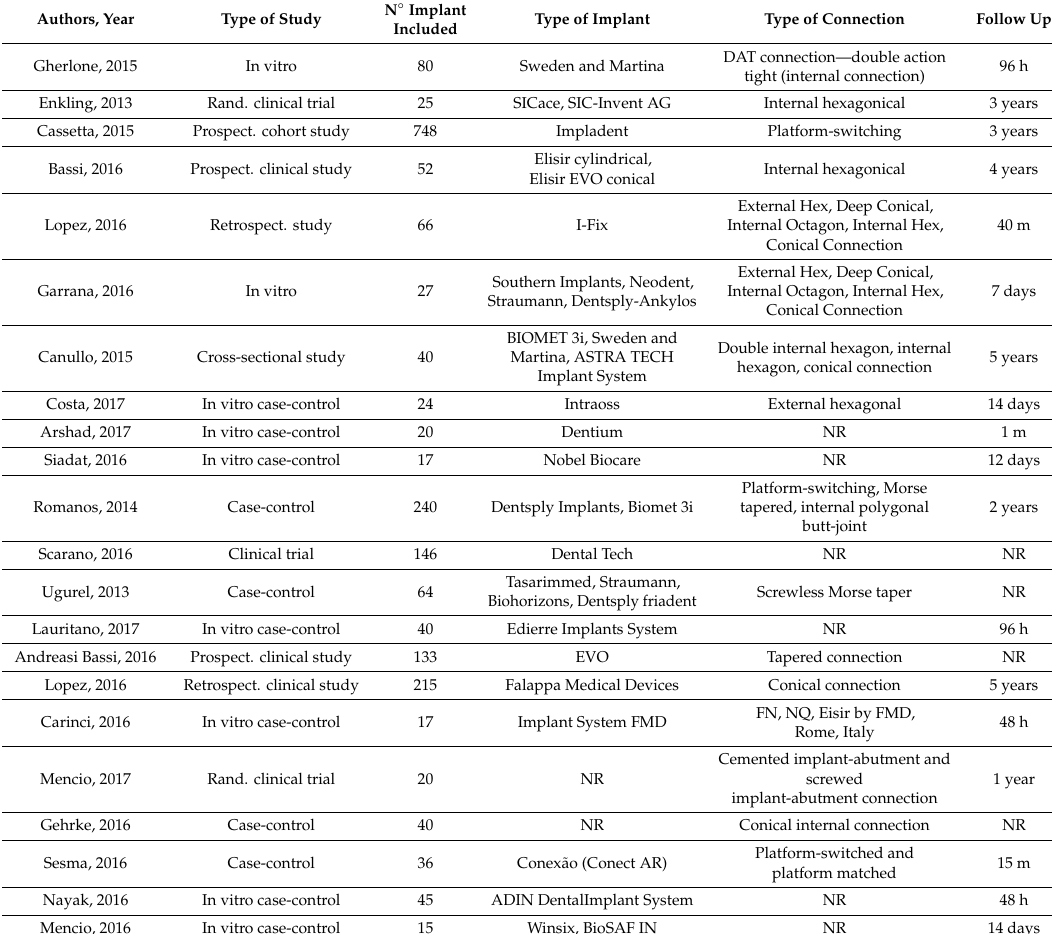
Table 2. Characteristic of implants included in the study and follow-up periods.